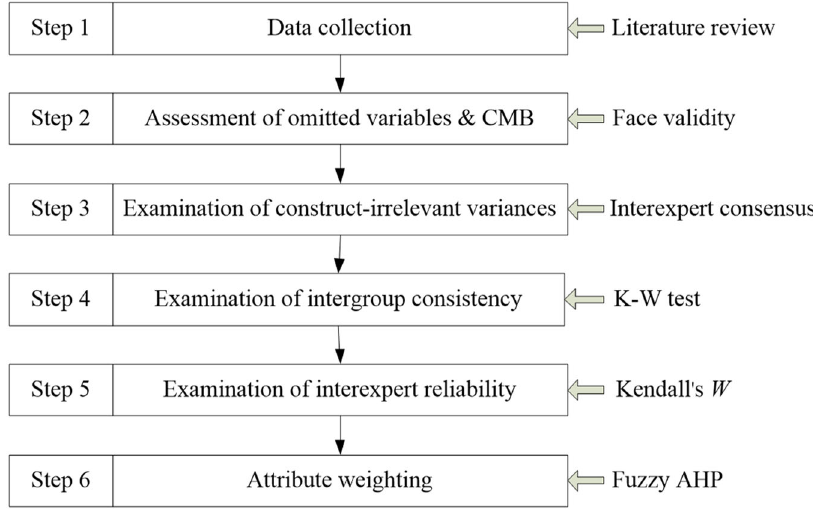
Fig. 1 Model development procedure. Steps required in developing the model for analysis after obtaining the